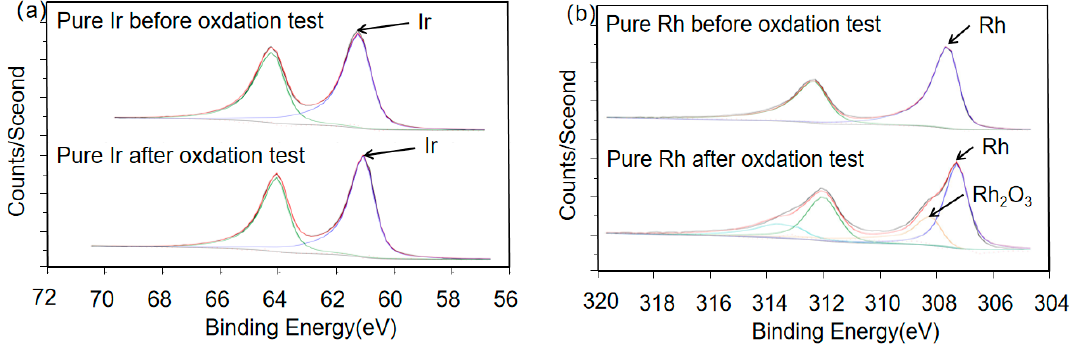
Figure 1. Ir 4f and Rh 3d spectra of ( a ) pure Ir and ( b ) pure Rh. Table 2. Peak values of X-ray photoelectron spectroscopy (XPS) test results before and after oxidation tests.